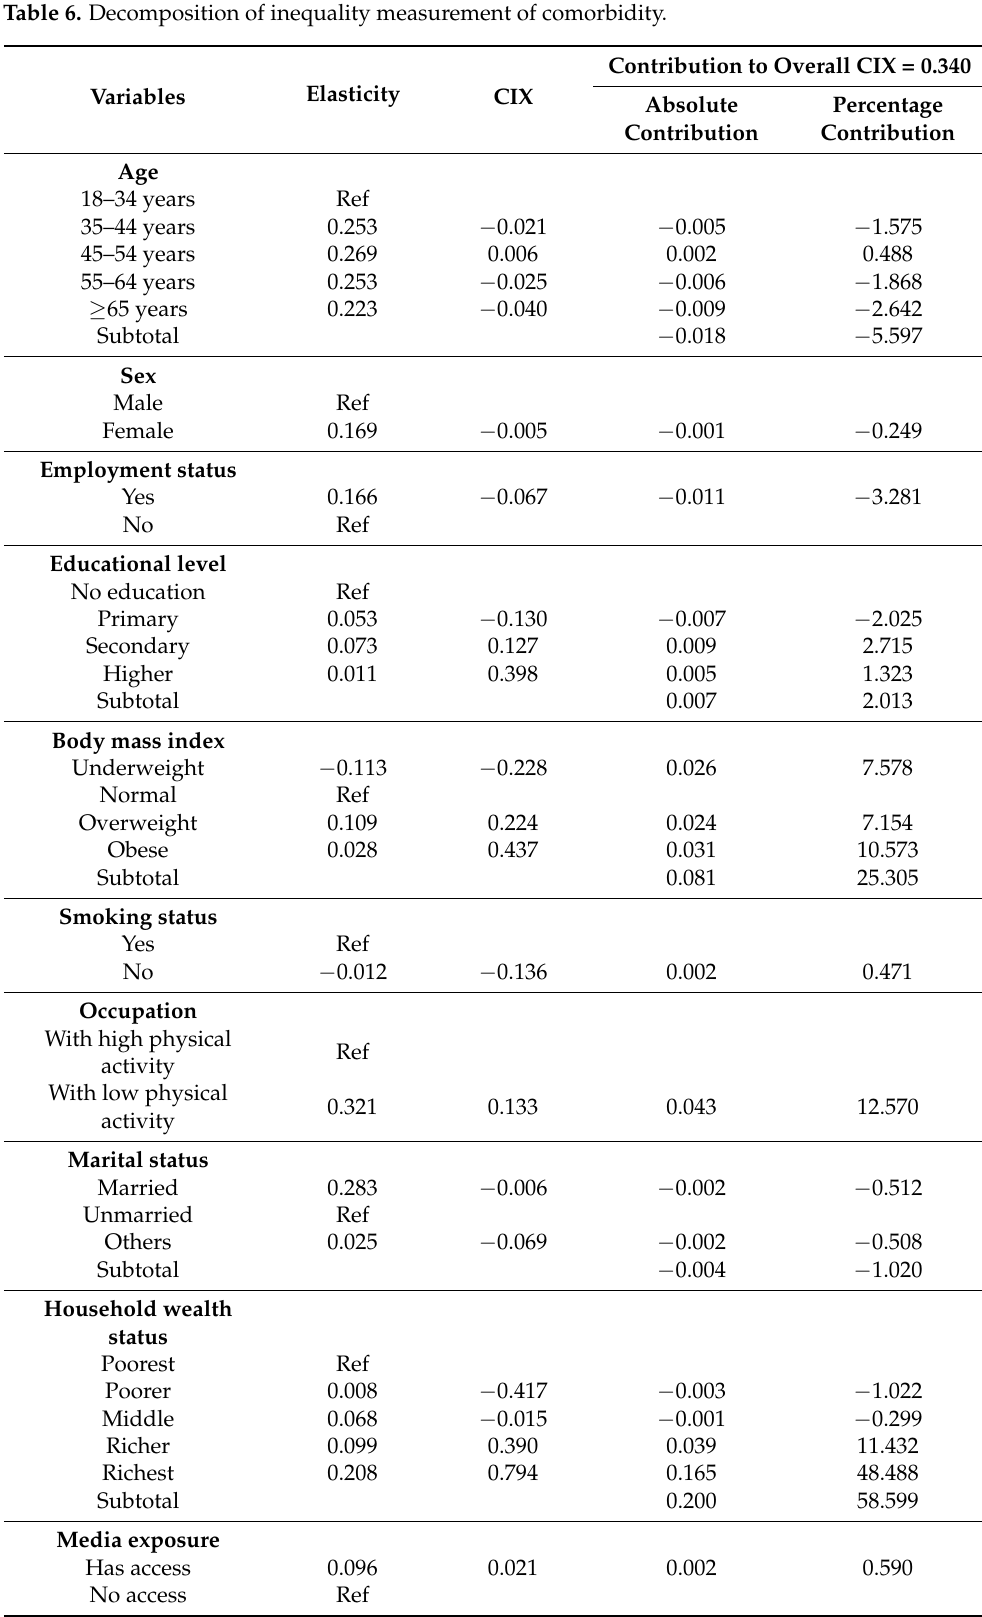
Table 6. Decomposition of inequality measurement of